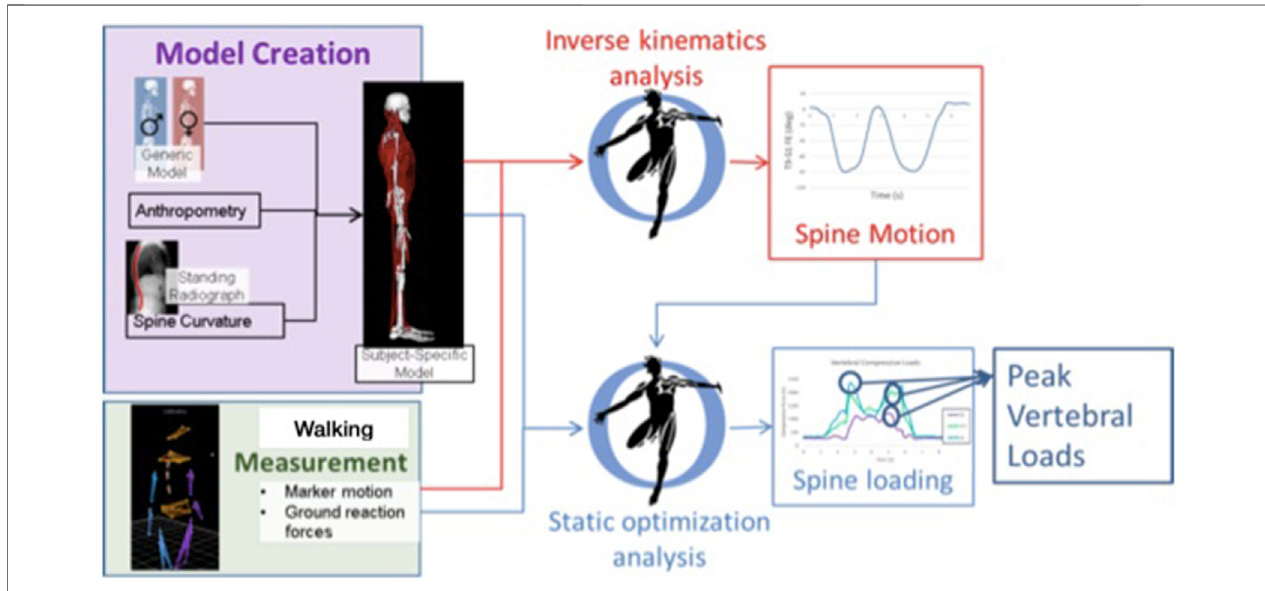
FIGURE 1 | Basic work fl ow for creating subject-speci fi c musculoskeletal model to determine spine motion and loading. Walking trials were measured, and outcomes of body motion and loading were evaluated for a single gait cycle in each trial. Spine loading was evaluated during standing and walking trials.